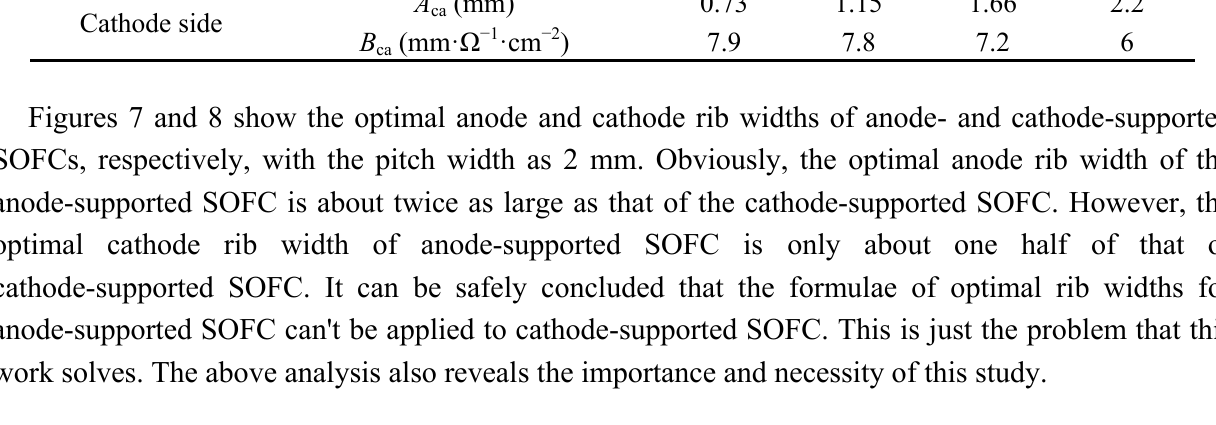
Figure 7. The optimal anode rib width of anode- and cathode-supported SOFC.